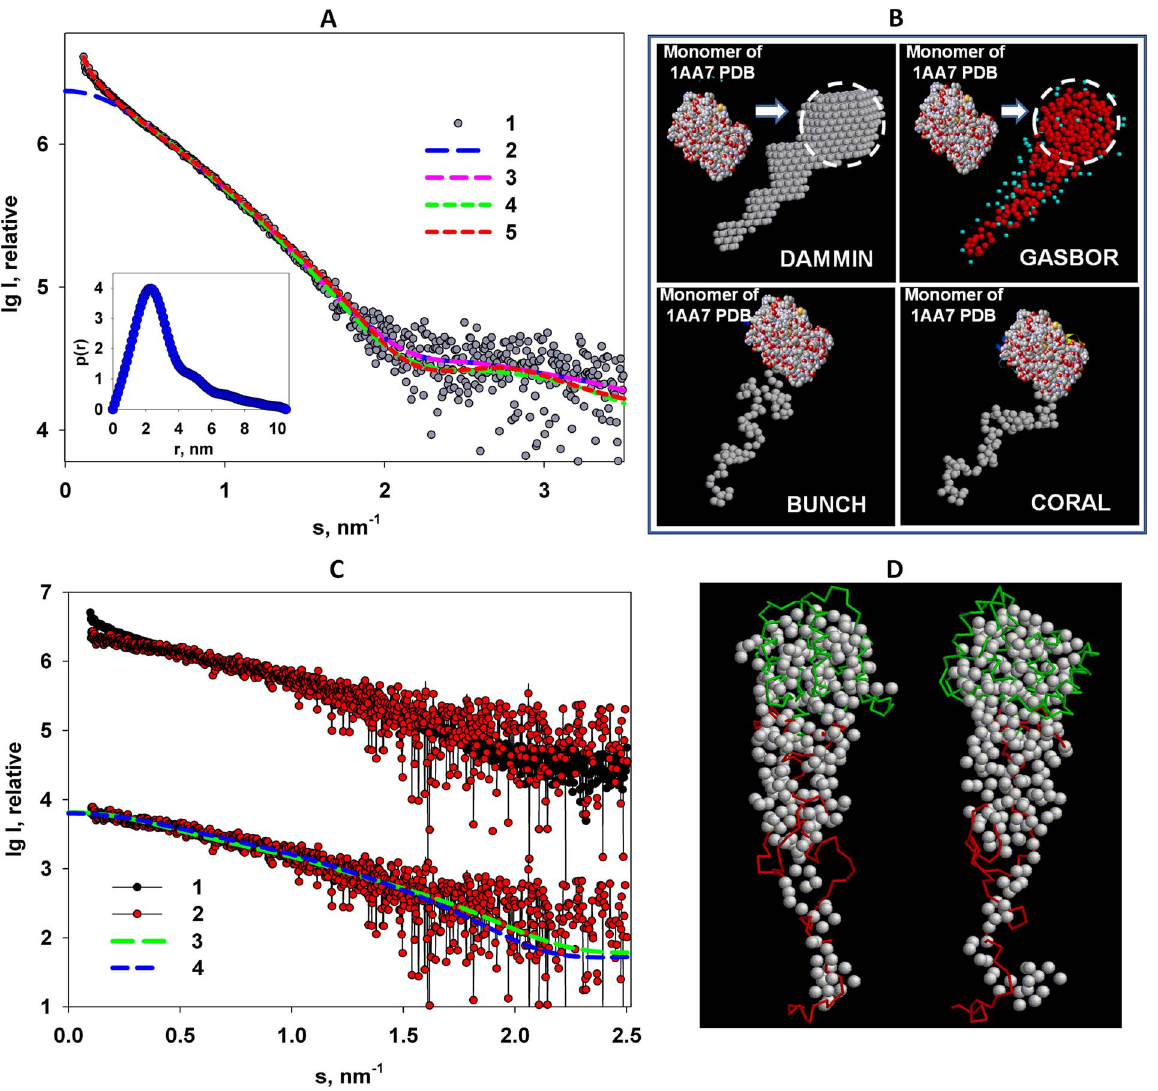
Figure 5. Shape restoration of full length M1. (A) Experimental SAXS data (1), the transformed from p ( r ) and extrapolated to zero scattering angle intensity (2), scattering patterns computed from the ab initio models (DAMMIN & GASBOR) in (B), top row (3), scattering patterns computed from the hybrid models (BUNCH & CORAL) in (B), bottom row (4), and the fit from the mixture computed by OLIGOMER (5). Insert: distance distribution function p ( r ) computed by GNOM. (B): structural models reconstructed by ab initio and by hybrid modeling programs. (C): Comparison of the experimental SAXS curve from M1 protein (1) with the SAXS profile that after passage of M1 through the chromatographic column (2), and the scattering patterns computed from the hybrid models in panel B: CORAL (3) and BUNCH (4). (D) Superposition of the ab initio model restored by GASBOR from the SAXS-SEC data (beads) with the BUNCH model reconstructed from the truncated raw M1 protein data (C a chain; green: N domain, red: C-terminus). The models represented on the left are a 90 u rotation of the models on the